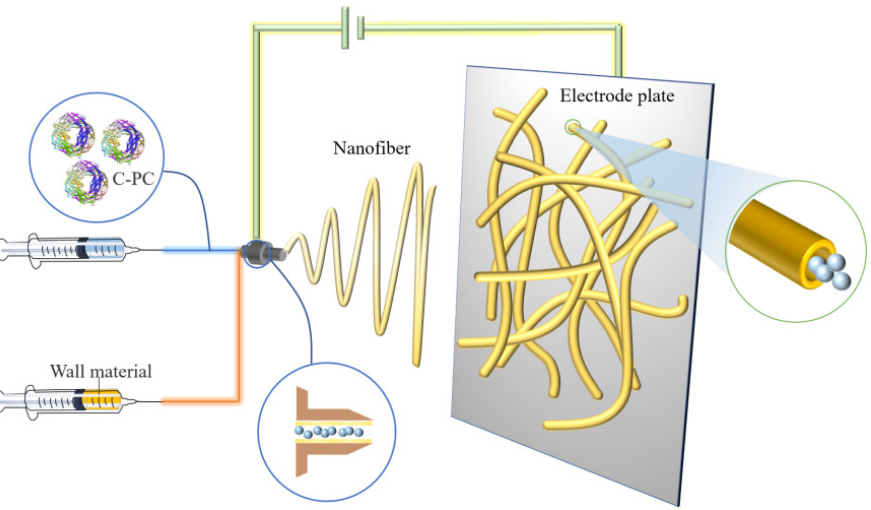
Figure 4. Schematic illustration of preparing PC microcapsules using the electrospinning